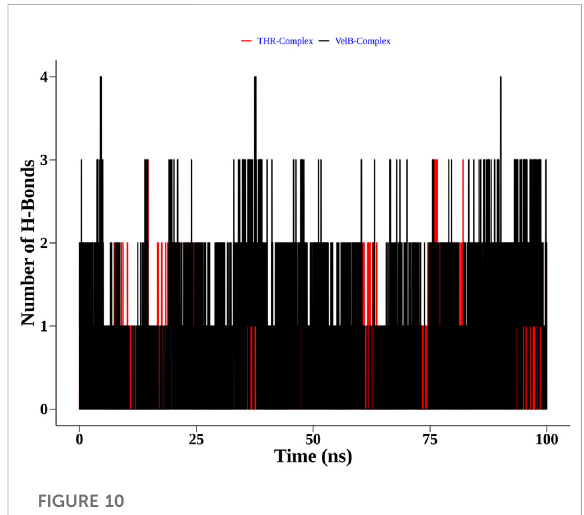
FIGURE 10 Distribution of the hydrogen bonds formed by curcumin with THR and VelB receptors at the binding